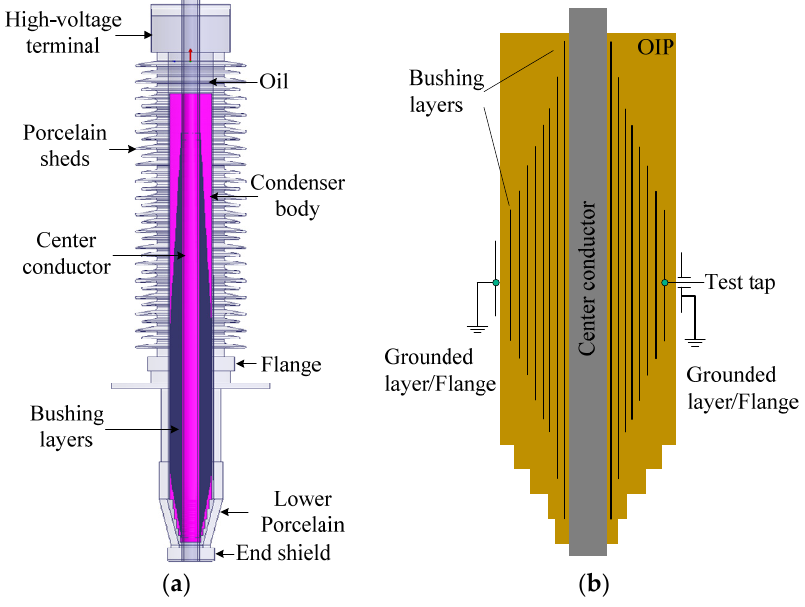
Figure 3. Illustration of an oil-impregnated paper (OIP) bushing (not to scale): ( a ) overall structure; ( b ) the condenser body.